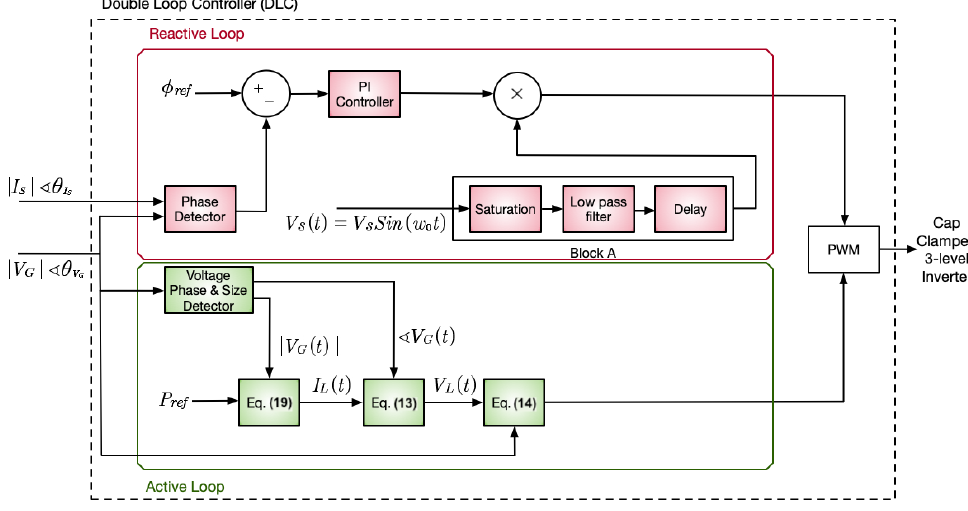
Figure 7. Block diagram of the proposed double-loop